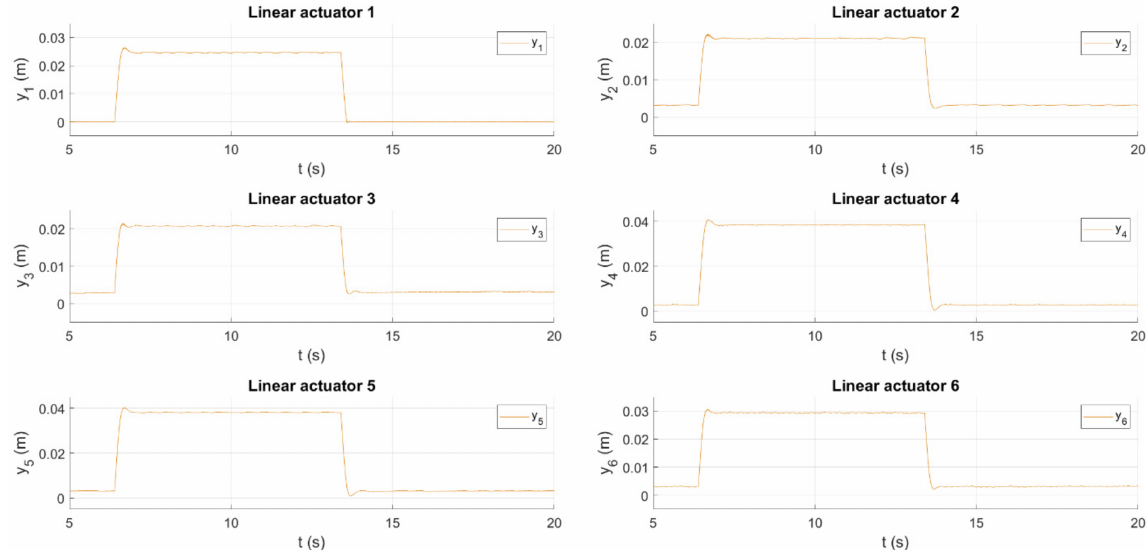
Figure 18. Actual piston rod extensions of the Stewart platform linear actuators